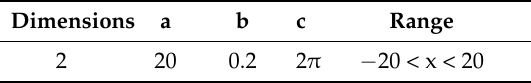
Table 2. Ackley benchmark constants.